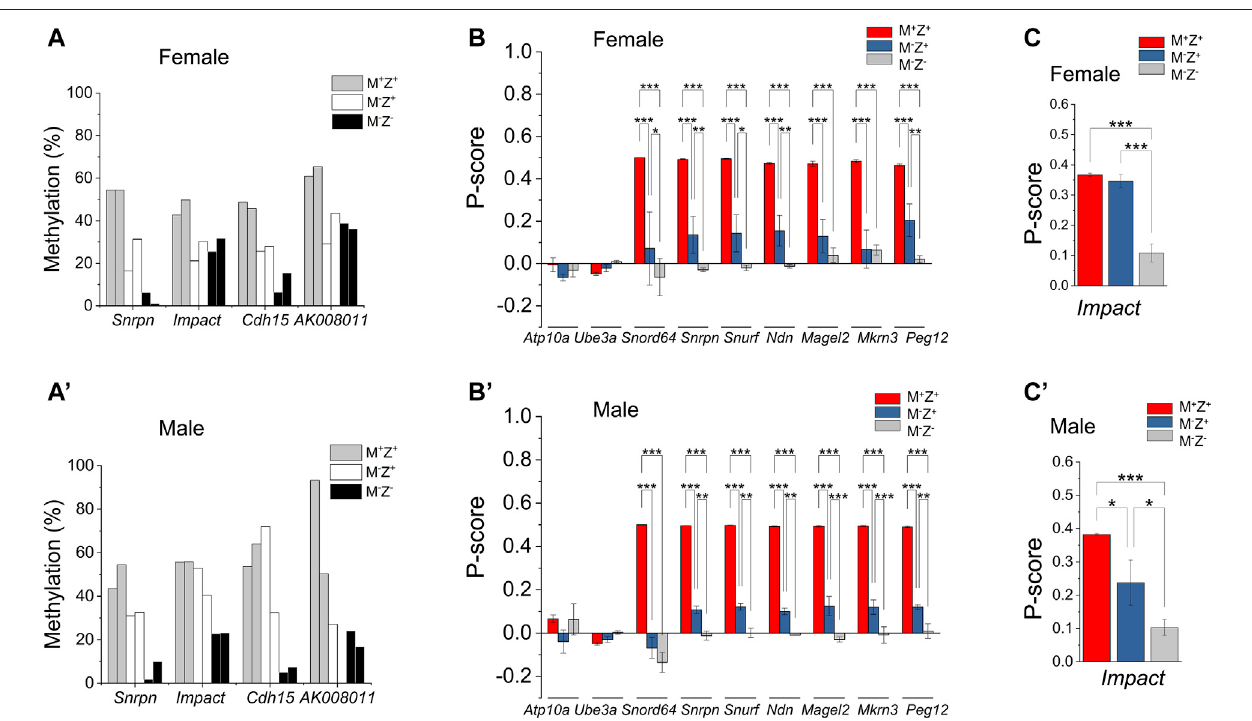
FIGURE 5 | Maternal effect of Zfp57 was observed on DNA methylation imprint in a few imprinted regions as well as on the expression of a few imprinted genes. Genomic DNA samples were isolated from the Zfp57 +/ − (M + Z + ), Zfp57 − /+ (M − Z + ), and Zfp57 − / − (M − Z - ) hybrid 129/DBA E13.5 embryos and subjected to whole-genome bisul fi te sequencing (WGBS) analysis (Jiang et al., 2021). Two female embryos of each genotype and two male embryos of each genotype were used in this study for examinationofDNAmethylationimprintattheimprintedregions.ForRNA-seqanalysis,atleastthreeRNAsampleswereusedforeachgenotype(M + Z + , M − Z + ,and M − Z - ) of the female or male embryos. (A,A ’ ) DNA methylation at the Snrpn , Impact , Cdh15 , and AK008011 ICRs in the female embryos (A) or male embryos (A ’ ) . (B,B ’ ) P-scorewascalculatedtomeasuretheexpressionofthepaternalallelesoftheimprintedgenesatthe Snrpn imprintedregioninthefemaleembryos (B) ormaleembryos (B ’ ) .Theseincludethe Atp10a , Ube3a , Snord64 , Snrpn , Ndn , Magel2 , Mkrn3 ,and Peg12 imprintedgenesatthe Snrpn imprintedregion.Two-wayANOVAwasusedfor statisticalanalysisoftheP-scoredifferencesofeachimprintedgeneinthefemaleM + Z + , M − Z + ,andM − Z - ormaleM + Z + , M − Z + ,andM − Z - embryos.Statisticalsigni fi cance: *, p < 0.05;**, p < 0.01;and***, p < 0.001. (C,C ’ ) P-scorewascalculatedtomeasurethepaternalalleleexpressionof Impact inthefemaleembryos (C) ormaleembryos (C ’ ) .One-wayANOVA wasused forstatisticalanalysisoftheP-score differences of Impact inthefemaleormaleembryos. Statisticalsigni fi cance:* p < 0.05;** p <